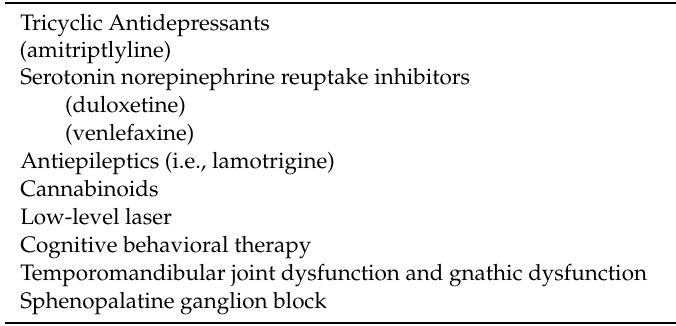
Table 4. Treatments for PIFP. The following treatments are used or have been proposed for use in treating PIFP. Unfortunately, none have su ffi cient evidence available to make an evidenced-based recommendation for